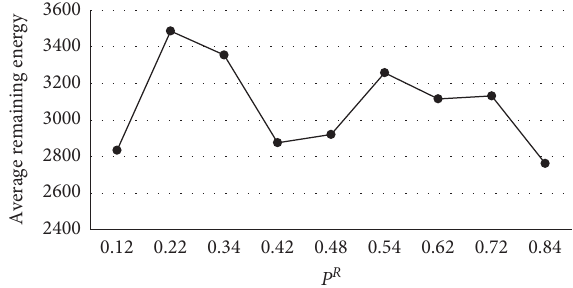
Figure 6: Average remaining energy of different disaster avoidance probabilities of